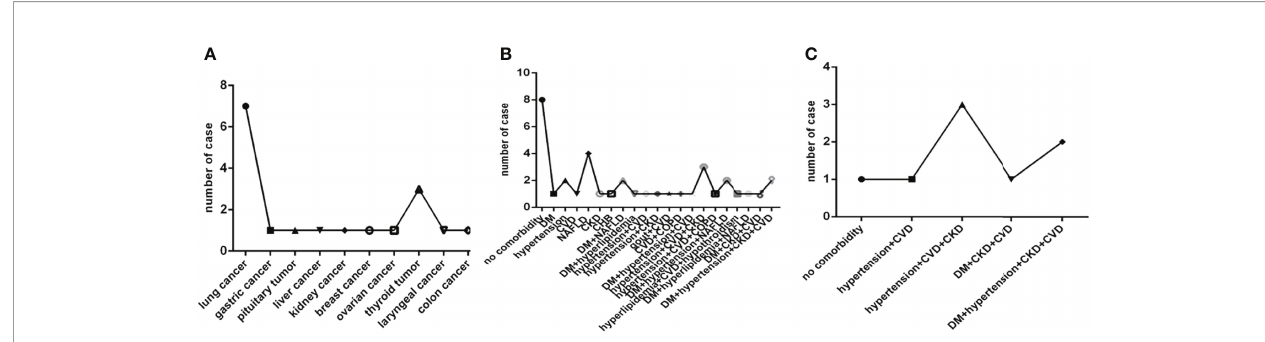
FIGURE 3 | Comparison of the distribution characteristics of the type of cancer in eighteen patients with cancer, the distribution characteristics of the number and type of comorbidities in thirty-seven severe COVID-19 patients and in eight deadly COVID-19 patients. COVID-19, coronavirus disease 2019. NAFLD, nonalcoholic fatty liver disease. DM, diabetes mellitus. CHB, chronic hepatitis (B) COPD, chronic obstructive pulmonary disease. CKD, chronic kidney disease. CVD, cardiovascular disease. (A) The type of cancer. (B) The number and type of comorbidities in severe COVID-19 patients. (C) The number and type of comorbidities in deadly COVID-19